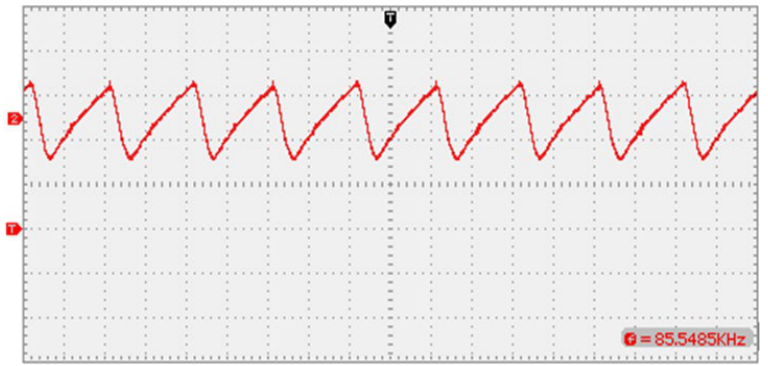
Figure 17. Capacitor voltage V C 1 (vertical scale 5 V/div). Voltage and current waveforms of diode D 2 are displayed in Figure 18. The diode is forward-bioased under ZCS at t 0 to flow I L 8 . Figure 18. Voltage ( top ) and current ( bottom ) waveforms of diode D 2 (vertical scale 100 V/div or 20 A/div). Voltage waveforms of resonant capacitors C 3 and C 4 are shown in Figure 19. In addition, current waveforms of resonant inductors L 5 and L 6 are depicted in Figure 20.